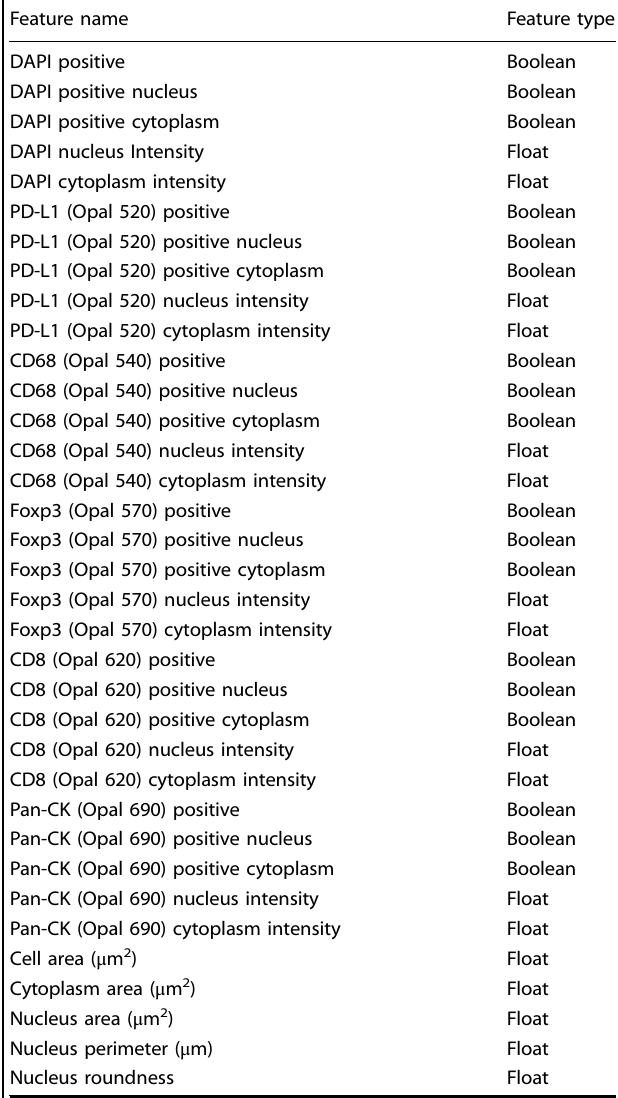
Table 1. The list of node attributes and their variable